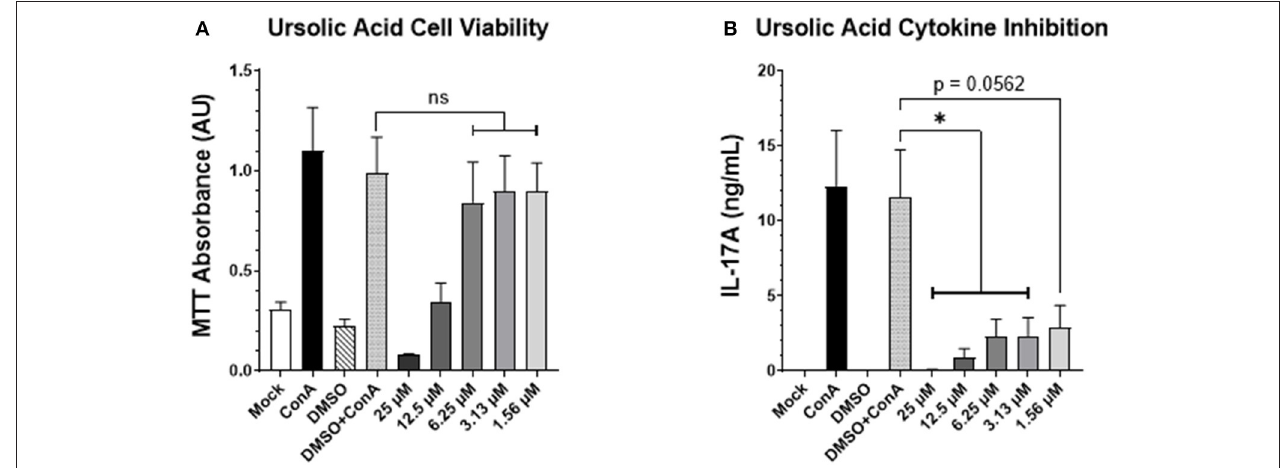
FIGURE 1 | UA suppresses mitogen-induced IL-17A production by bovine PBMCs. Peripheral blood mononuclear cells from three healthy bovids were plated at 3 × 10 5 cells per well in a 96-well plate and incubated with Concanavalin A, vehicle control (DMSO), or escalating concentrations of UA dissolved in DMSO for 3 days. On day three, cell supernatants were collected, and the remaining cell pellet was re-suspended with an MTT solution using the manufacturer’s protocol to subsequently analyze the viability of the cells after the incubation period. (A) Mean absorbance values at 570nm ± SEM following the MTT incubation and solubilization. Significance was determined using a one-way ANOVA with Tukey’s multiple comparisons; (ns) indicates no significant differences were observed. (B) The supernatants from the 3-day incubation were analyzed for IL-17A concentration by ELISA. Data represent mean IL-17A concentration (in ng/mL) ± SEM detected in the supernatants. The data were analyzed using a standard one-way ANOVA with Tukey’s multiple comparisons; * p <